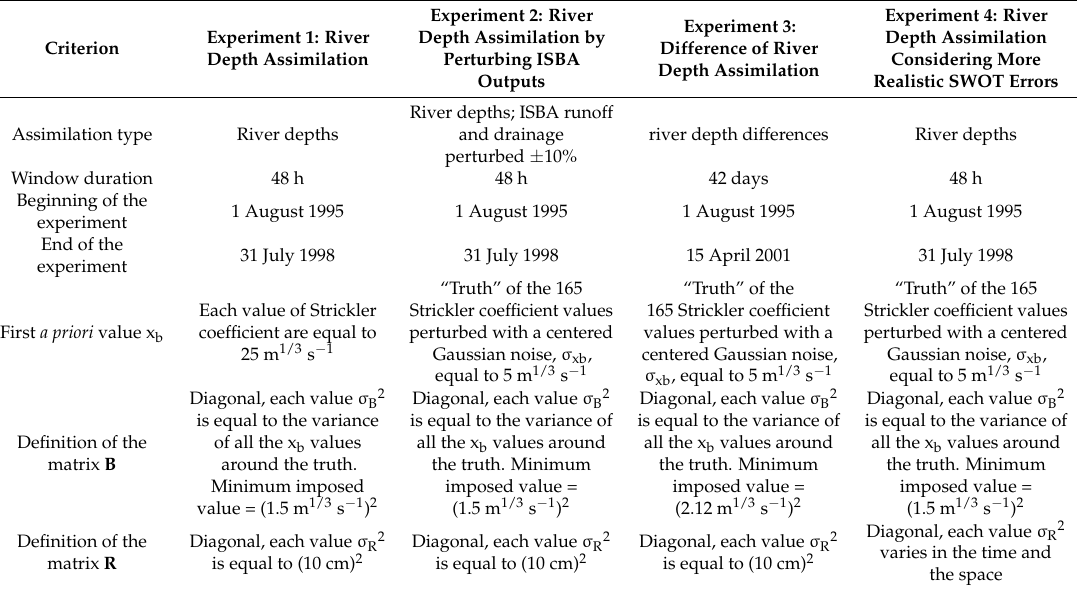
Table 3. Synthetic description of the four SWOT DA